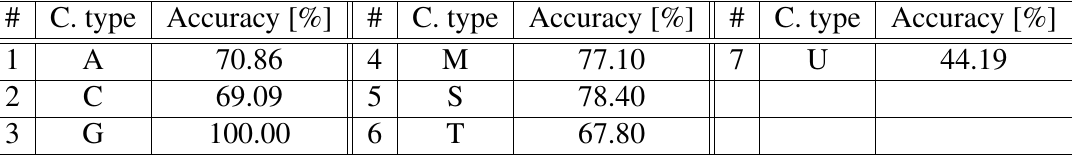
Table 6: Accuracy values for the SVM system by catalytic